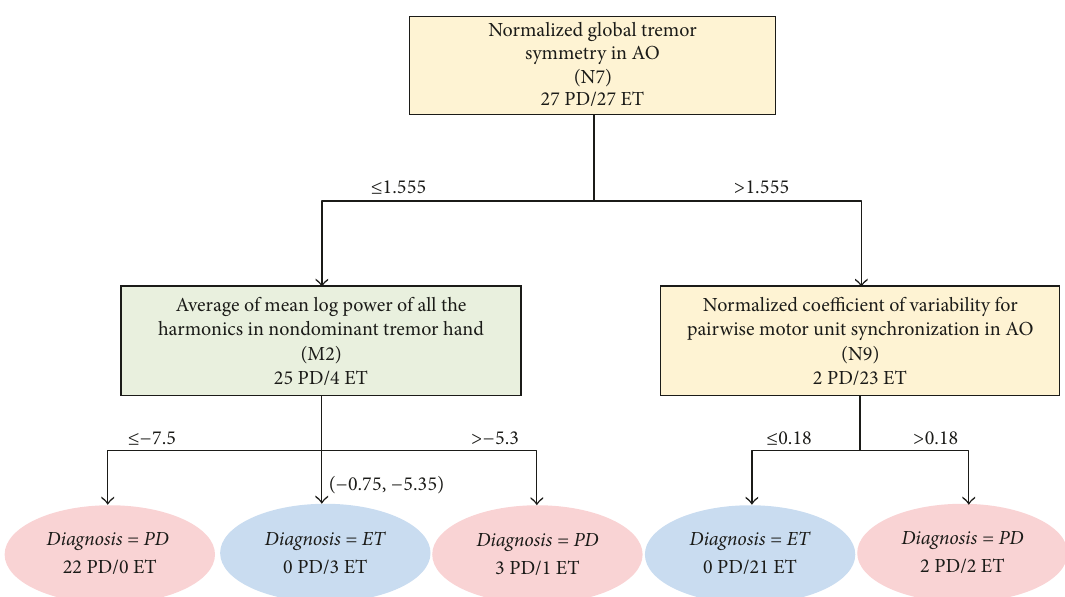
Figure 8: Decision tree, induced by CHAID algorithm on the data from 27 ET and 27 PD patients. Rectangles depict neural drive (yellow) and movement (green) metrics. Red and blue ellipses depict PD and ET diagnosis, as predicted by the model. “Normalized global tremor symmetry in AO” (N7) metric discriminated 25 PD and 23 ET patients. Additional 3 ET and 2 PD patients were discriminated by “average of mean log power of all the harmonics in non-dominant tremor hand” (M2) and “normalized coefficient of variability for pairwise motor unit synchronization in AO” (N9) metrics, respectively. Three ET patients were misdiagnosed by this